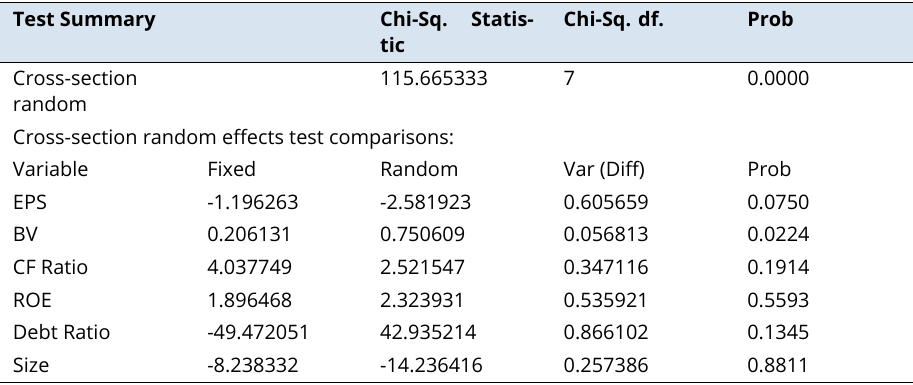
Hausman Test of Post IFRS Period -2004 to